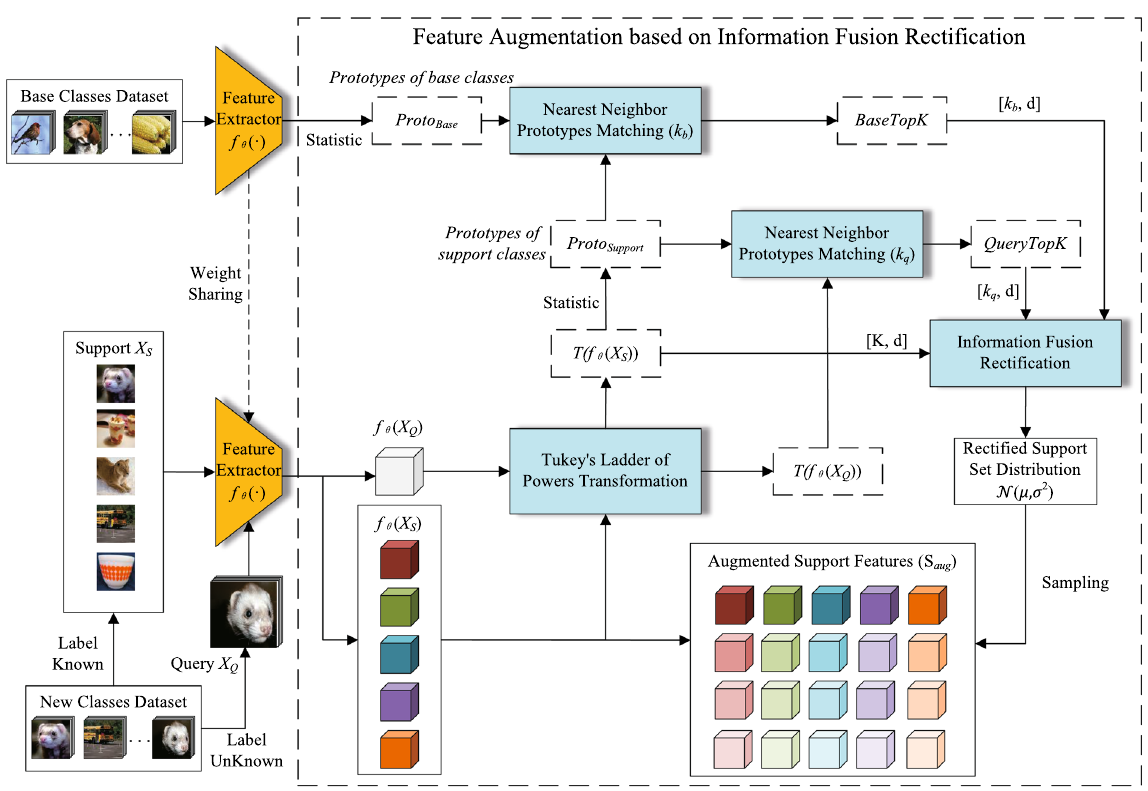
Figure 1. Feature augmentation based on information fusion